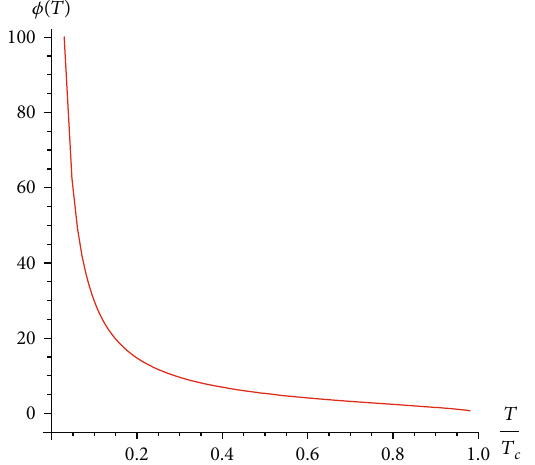
Figure 4: The ϕ ð T Þ − T / T black hole with T ≤ T